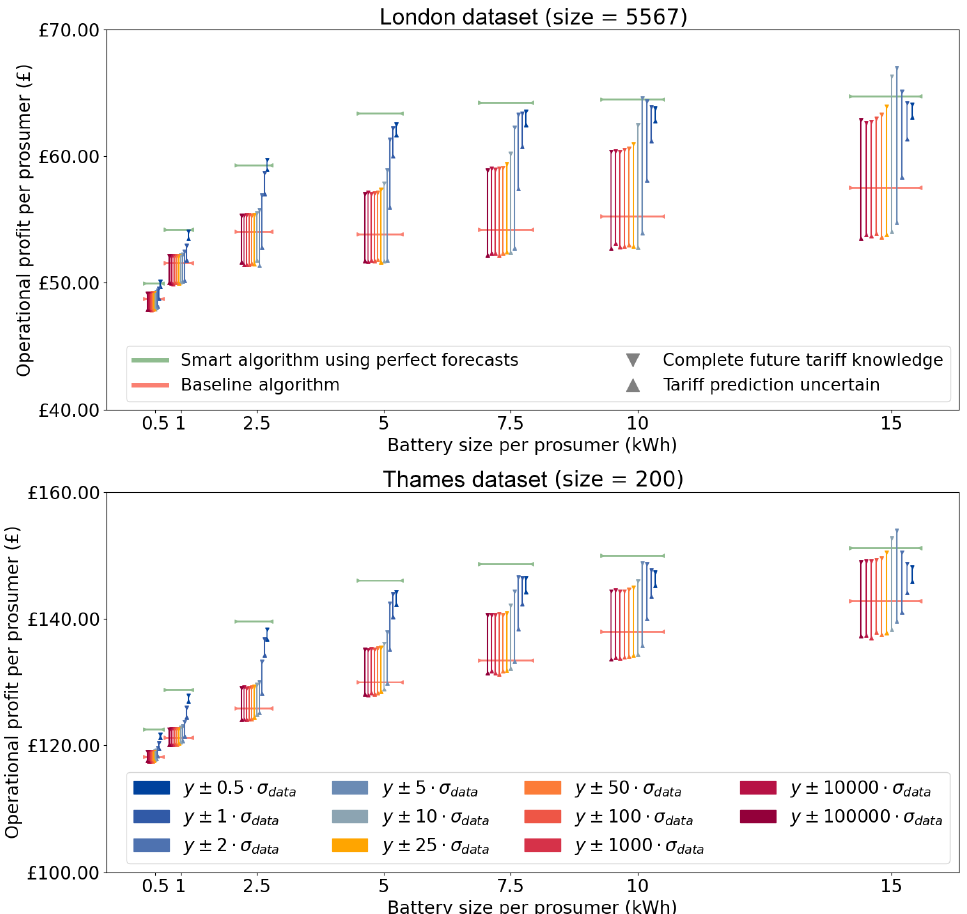
Figure 11. High-level comparison between operational profits of the baseline algorithm and smart al- gorithm for the average prosumer using various battery sizes and lookahead amounts with uncertain forecasts based on constant margins. The legend in each graph applies to both graphs.